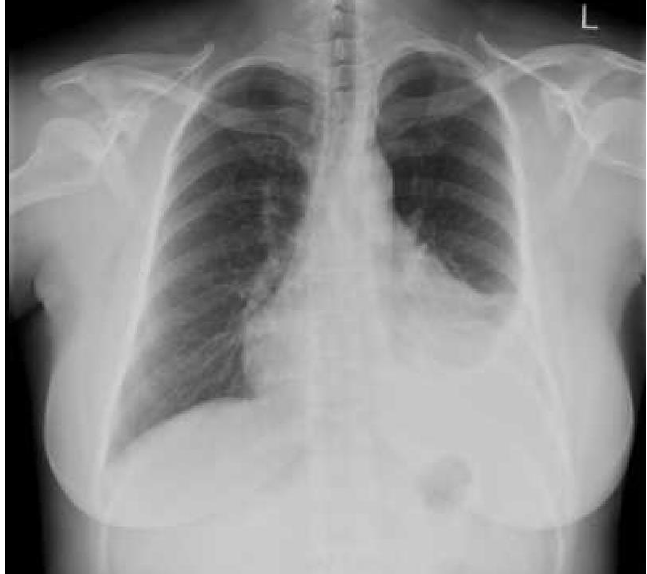
Figure 5. Chest radiograph ( CXR) demonstrating a pleural effusion.